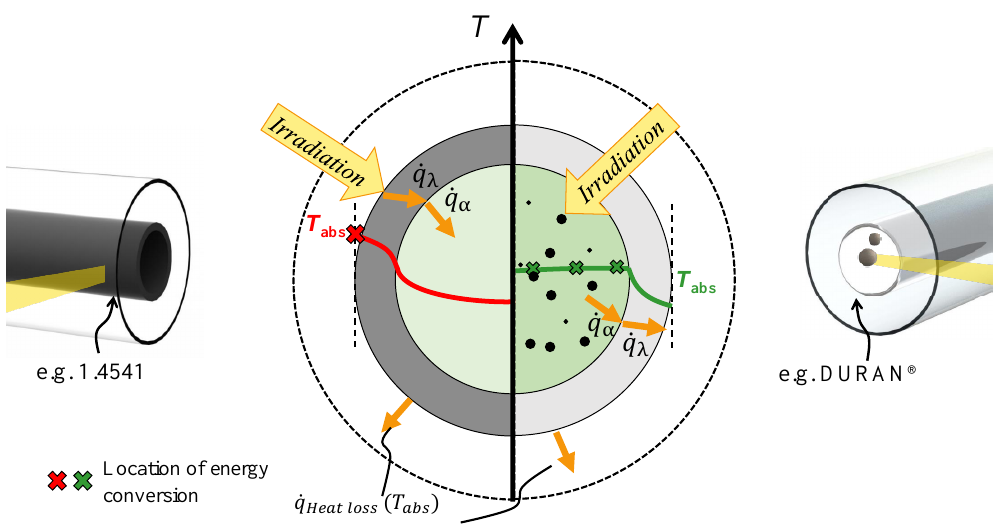
Figure 1. The figure illustrates that the location of radiation absorption is relocated from the outer surface into the absorber fluid. This results in a different temperature distribution and lower surface